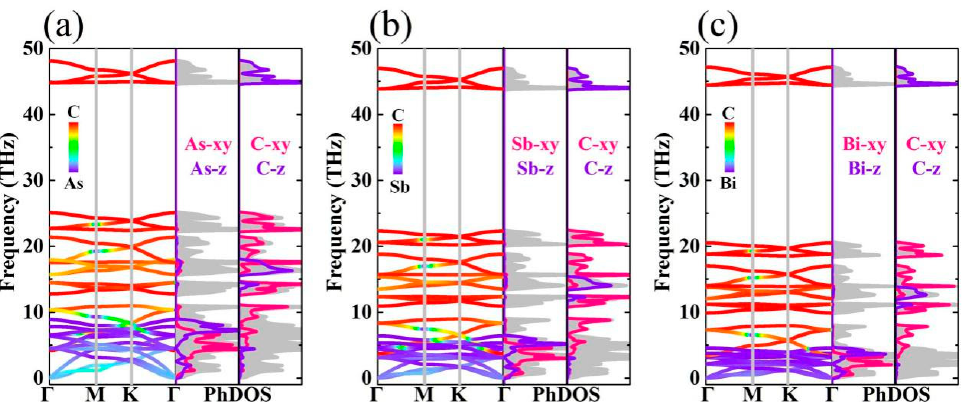
Figure 3. The orbital-resolved phonon spectra and corresponding phonon density of states (PhDOS) for ( a ) As 2 C 3 , ( b ) Sb 2 C 3 , and ( c ) Bi 2 C 3 .